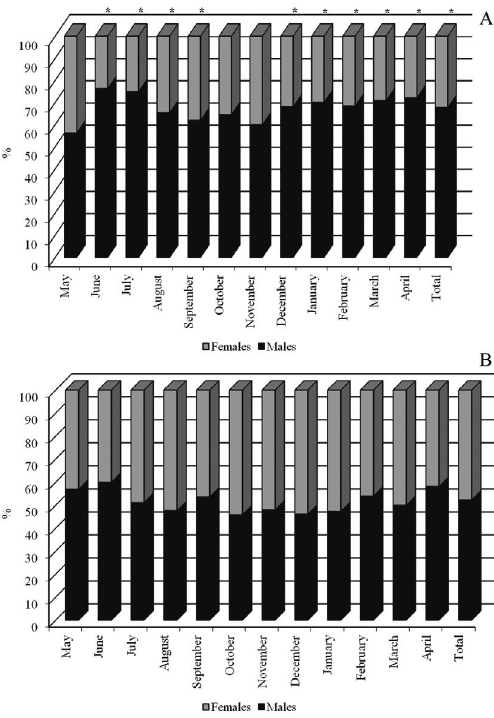
Figure 3. Aegla manuinflata : Sex-ratio of males and fe- males captured in the Passo Taquara stream, São Pedor do Sul, Rio Grande do Sul state, Brazil. A: All data included. B: sex-ratio considering only animals caught in the hand- net. Markings (*) indicate significant difference in the sex-ratio, according with the Chi-square test (p <